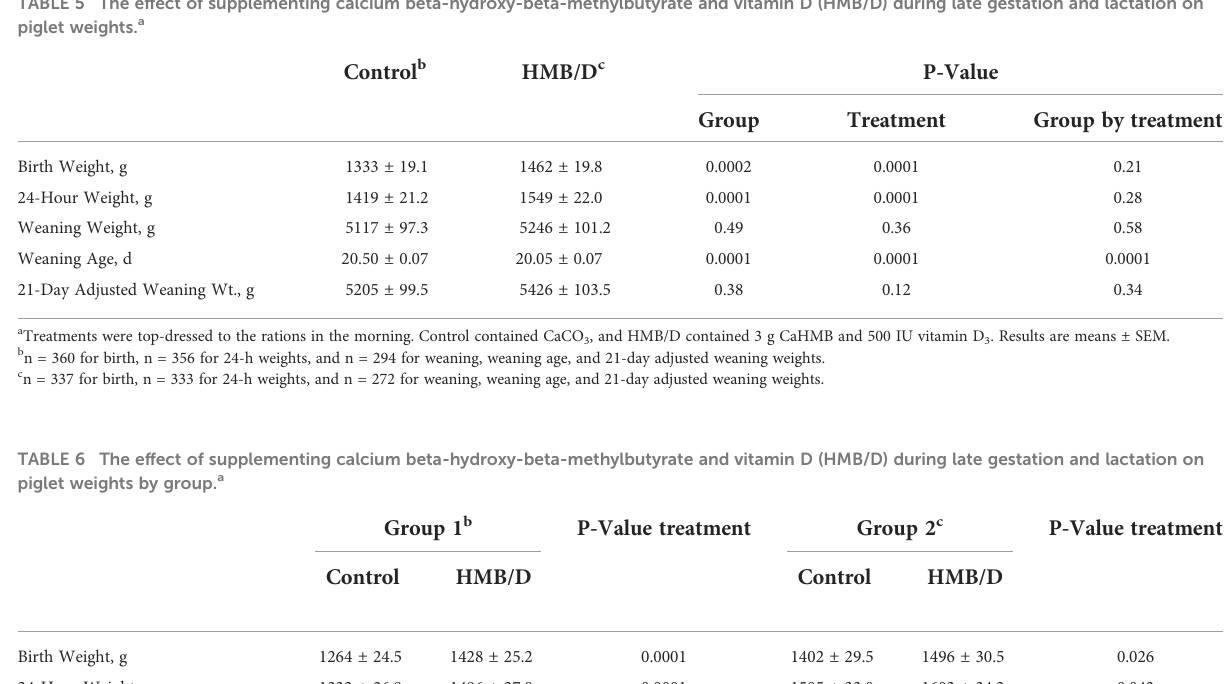
TABLE 5 The effect of supplementing calcium beta-hydroxy-beta-methylbutyrate and vitamin D (HMB/D) during late gestation and lactation on piglet weights. a